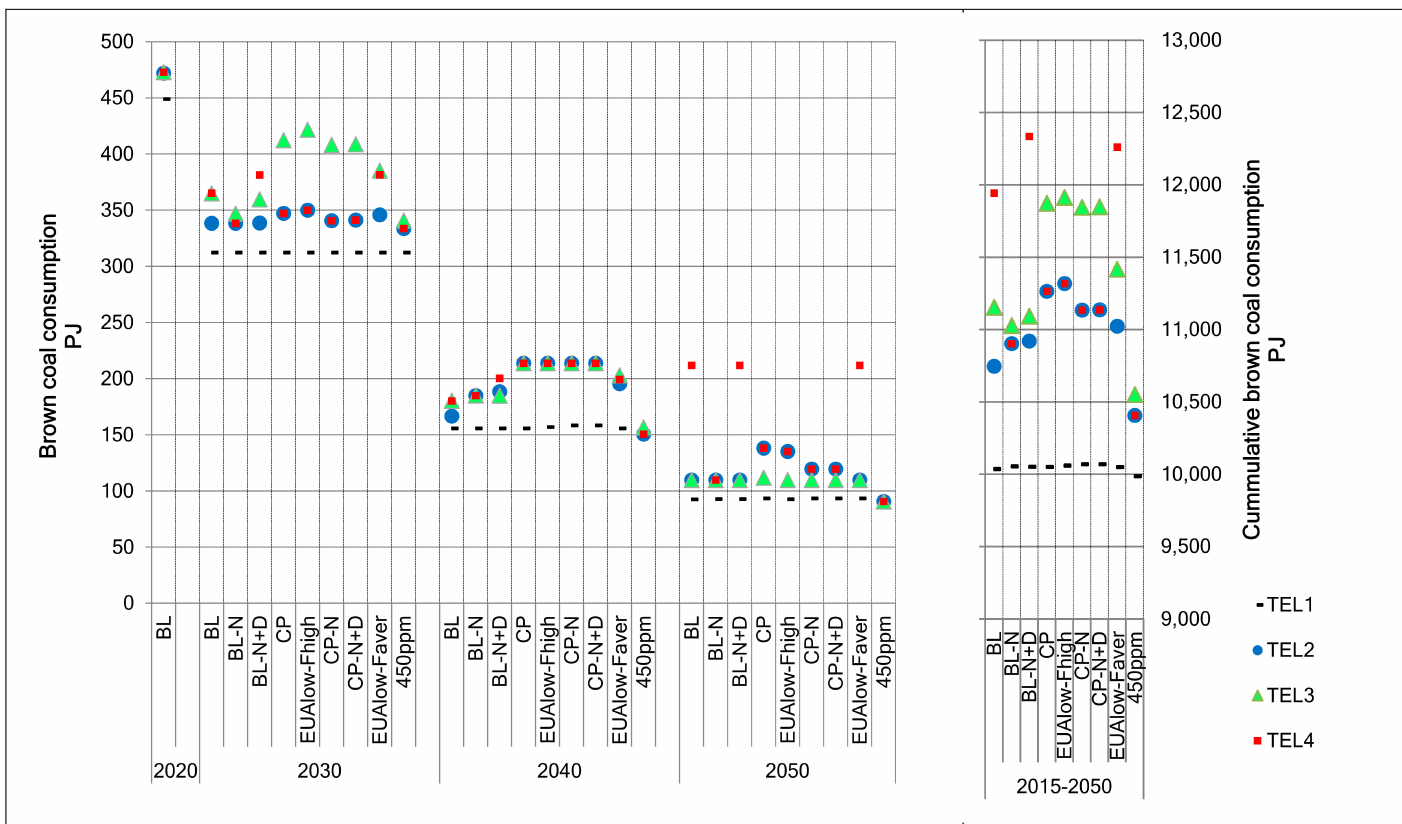
Figure 5. Brown coal consumption in 2020, 2030, 2040, 2050 and cumulatively 2015–2050. Note: The level of brown coal consumption is the same for all assumption sets in